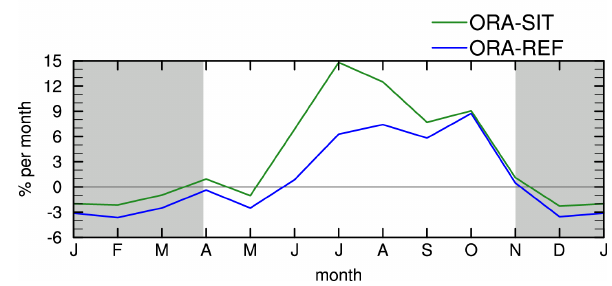
Figure 4. Annual cycle of the mean of the SIC increments in ORA- SIT (green) and ORA-REF (blue), averaged over the area north of 70 ◦ N during 2011–2016. The grey shading shows months (January to March and November to December) with CS2SMOS SIT nudg-